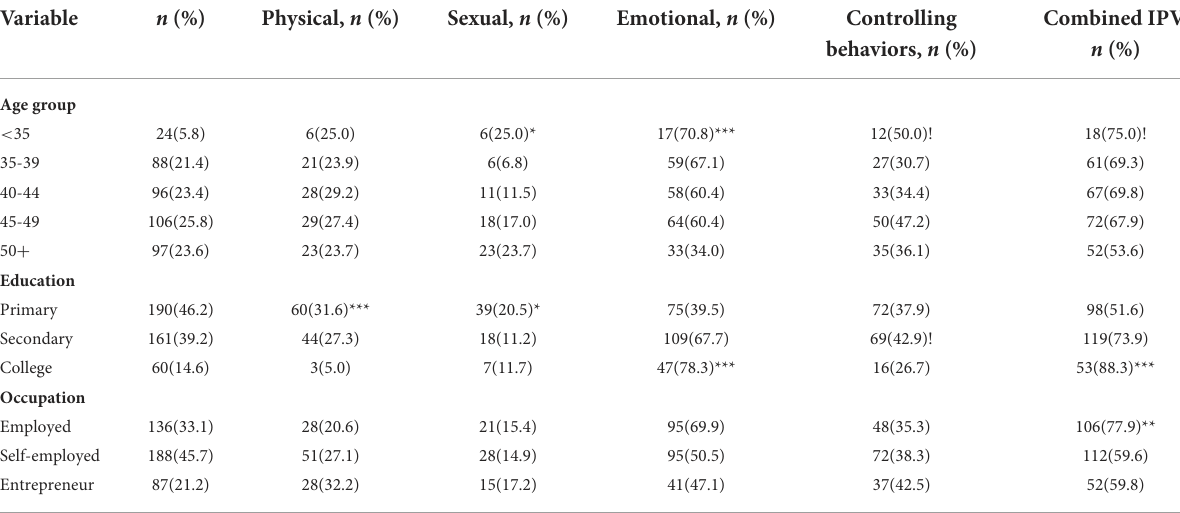
TABLE 4 Bivariate analysis showing demographic factors among partners associated with intimate partner iolence.